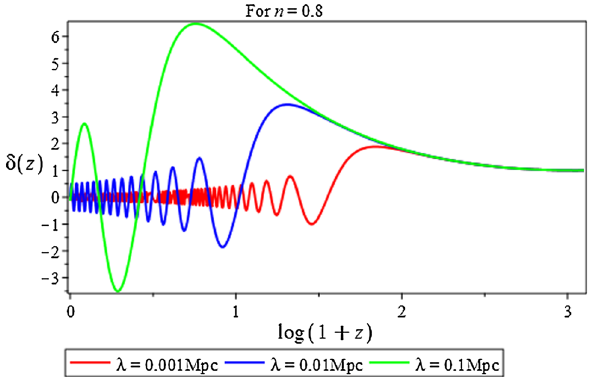
Fig. 9 δ( z ) versus z for Eq. (112) for short-wavelength mode for dif- ferent λ at n = 0 . 8